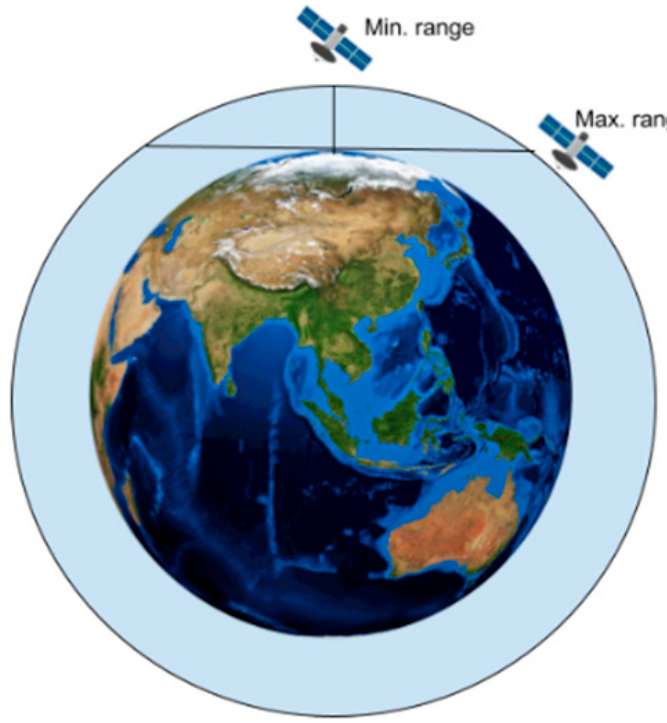
Figure 1. Slant range variation according to the satellite’s position.